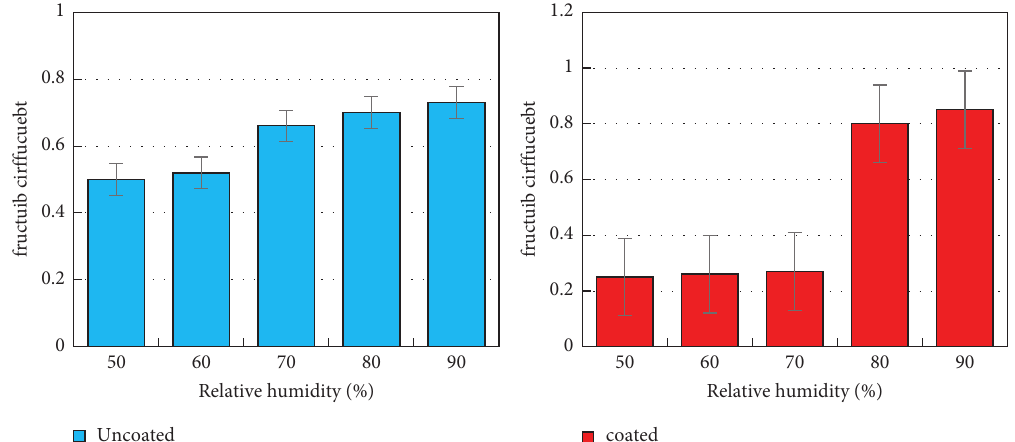
Figure 7: Abrasion resistance of cardboard base paper and coated modified paper under different relative humidity conditions.